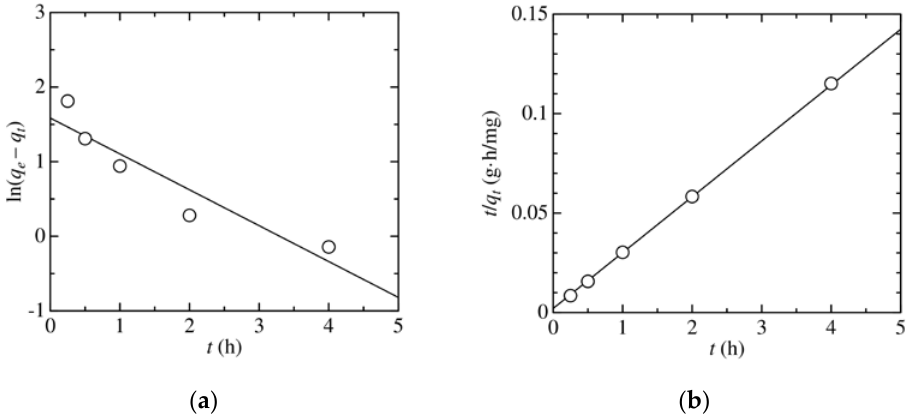
Figure 12. MO adsorption kinetics of the DA5 sample (dosage = 0.5 g/L, initial concentration = 20 mg/L, initial pH = 6.9, temperature = 301 K): ( a ) pseudo-first-order plots ( q e = 36 mg/g) and ( b ) pseudo-second-order plots. Table 4. Values of parameters for MO adsorption kinetic models.